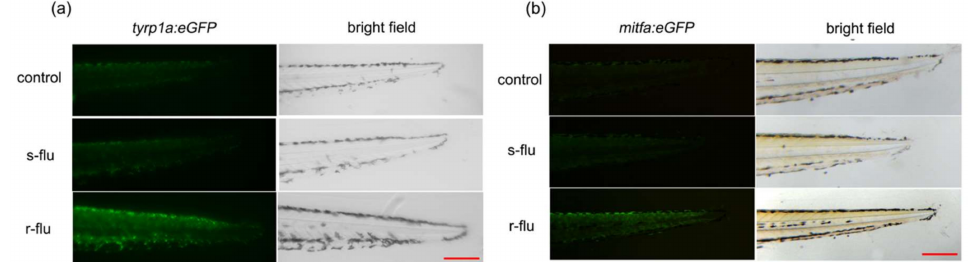
Figure 5. Effect of the r-fluoxetine and the s-fluoxetine on the gfp expression of the tyrp1a:eGFP and the mitfa:eGFP zebrafish. ( a ) tyrp1a:eGFP zebrafish and ( b ) mitfa:eGFP zebrafish Synchronized embryos were treated with 0.2 mM 1-phenyl-2-thiourea (PTU) at 6 hpf. r-fluoxetine (100 µ M) and s-fluoxetine (100 µ M) were added and incubated for a further 25 h, after a PTU wash at 35 hpf. Scale bar, 100 µ m.